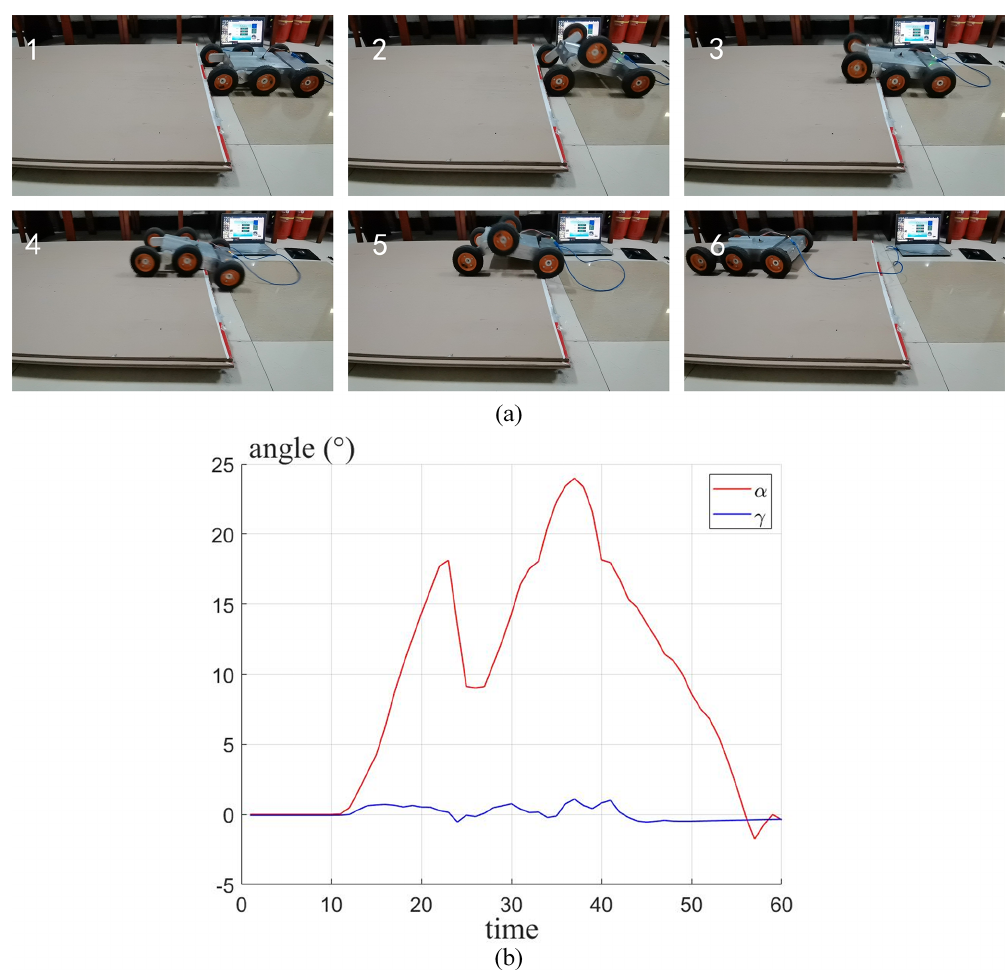
Figure 23. Experiment of the robot climbing 80mm vertical obstacle bilaterally and the curves of the pitch and roll angle of the robot obstacle